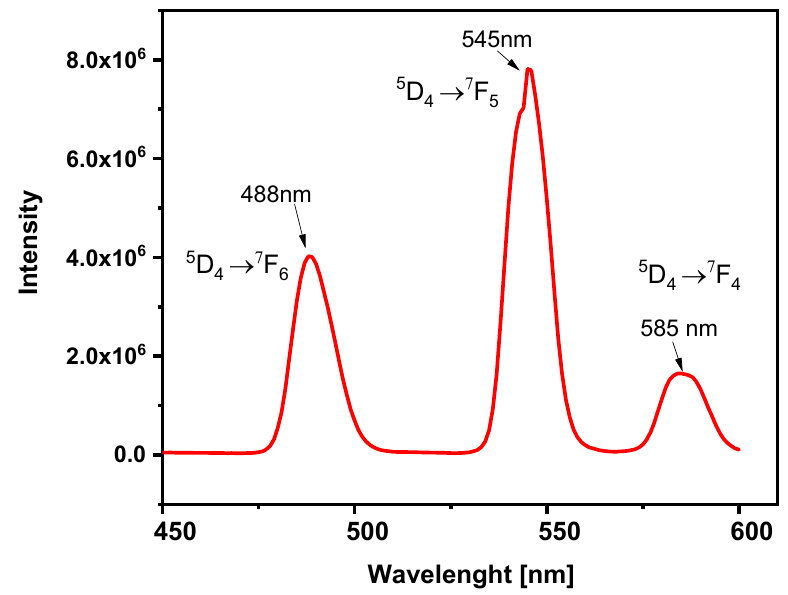
Figure 7. Fluorescence spectrum of IONPs@CA_GMP_Tb 3+ .